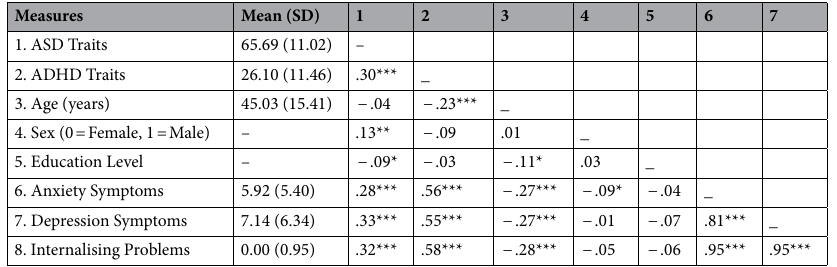
Table 1. Descriptive Statistics and Pearson’s Correlations. * p < .05, ** p < .01, *** p < .001.